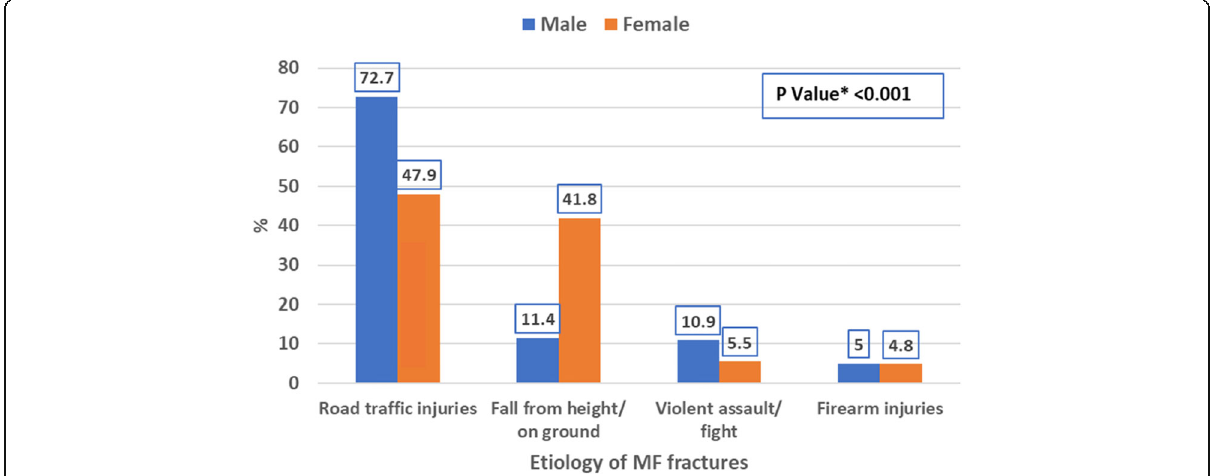
Fig. 3 Etiology of craniomaxillofacial fractures regarding gender in the studied sample. *Chi-square test